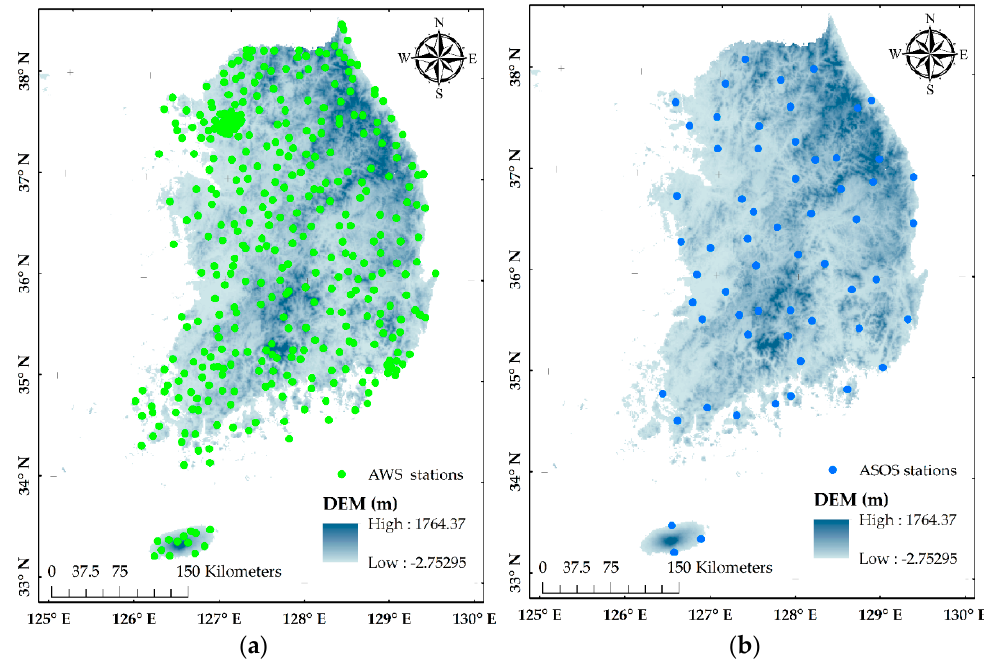
Figure 1. The elements of this study; ( a ) Automatic Weather Stations (AWS), ( b ) Automated Synoptic Observation System (ASOS).